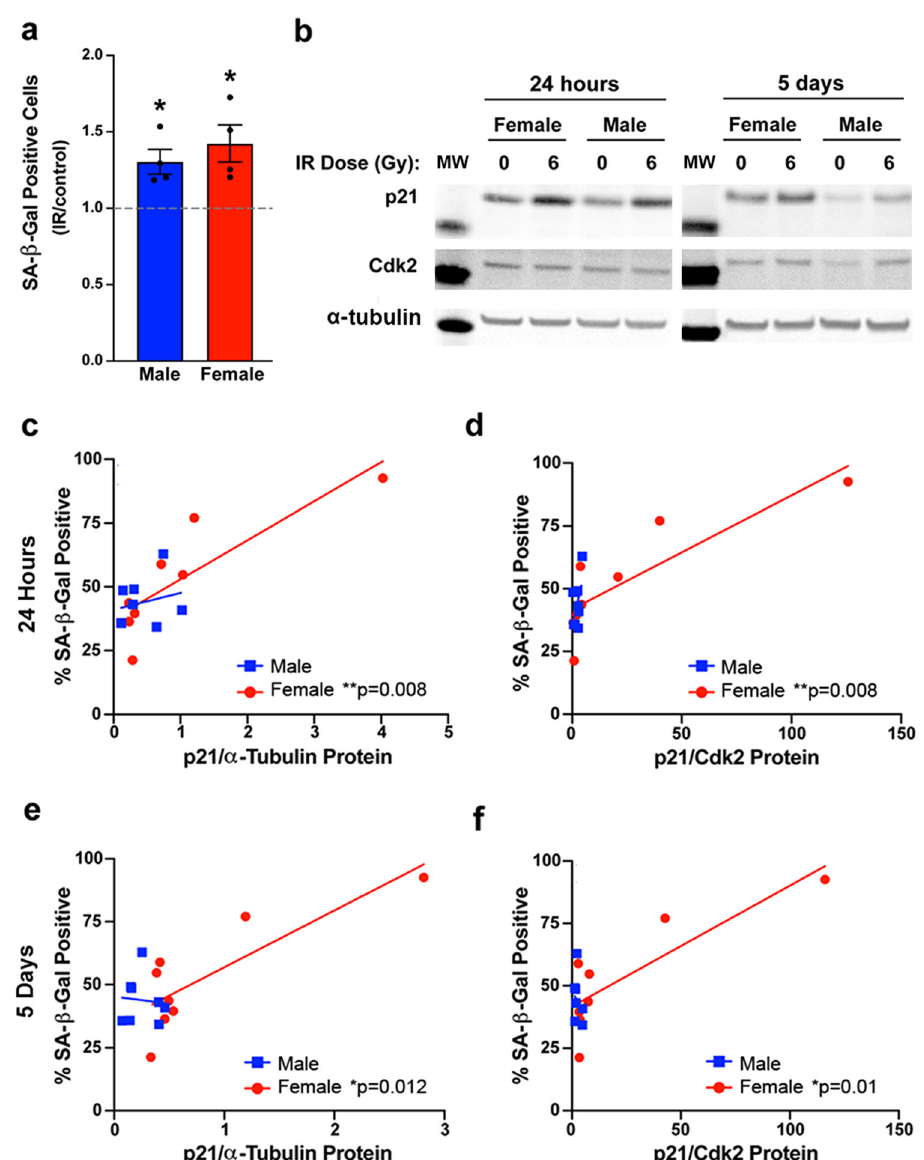
Fig. 6 Primary human GBM lines exhibit sex differences in the relationship between p21 and SA- β -gal positivity. a Fold change (irradiated/control) in the percentage of SA- β -gal positive cells 5 days after irradiation with 0 or 6 Gy in four male and four female primary human GBM lines. * p = 0.0329 (male) and * p = 0.0401 (female). b Representative western blot images of p21 and Cdk2 24 h and 5 days after irradiation with 0 or 6 Gy in male and female human GBM lines. Molecular weight markers (MW): p21 (15 kDa), Cdk2 (30 kDa), α -Tubulin (50 kDa). c Correlation between p21 protein levels at 24 h after irradiation with 0 or 6 Gy and the percentage of SA- β -gal positive cells at 5 days after irradiation in male and female human GBM lines. Male correlation: r = 0.23, p = 0.5783, female correlation: r = 0.85, p = 0.008 ( n = 8/sex). d Correlation between the p21/Cdk2 protein ratio at 24 h after irradiation with 0 or 6 Gy and the percentage of SA- β -gal positive cells at 5 days after irradiation in male and female human GBM lines. Male correlation: r = 0.54, p = 0.1649, female correlation: r = 0.85, p = 0.0081 ( n = 8/sex). e Correlation between p21 protein levels at 5 days after irradiation with 0 or 6 Gy and the percentage of SA- β -gal positive cells at 5 days after irradiation in male and female human GBM lines. Male correlation: r = − 0.09, p = 0.8408, female correlation: r = 0.83, p = 0.0115 ( n = 8/sex). f Correlation between the p21/Cdk2 protein ratio at 5 days after irradiation with 0 or 6 Gy and the percentage of SA- β -gal positive cells at 5 days after irradiation in male and female human GBM lines. Male correlation r = − 0.27, p = 0.5179, female correlation: r = 0.84, p = 0.0099 ( n = Fig. 2e, female Cas9 control cells exhibited sustained γ H2AX foci compared to male Cas9 control cells (Fig. 7e). Similar to the effects of p21 knockdown on senescence, the kinetics and magnitude of γ H2AX foci resolution following irradiation with 3 or 8 Gy was unaffected by p21 status in male cells (Fig. 7f). In contrast, the kinetics and magnitude of γ H2AX foci resolution after treatment with 8 Gy were signi fi cantly increased in female